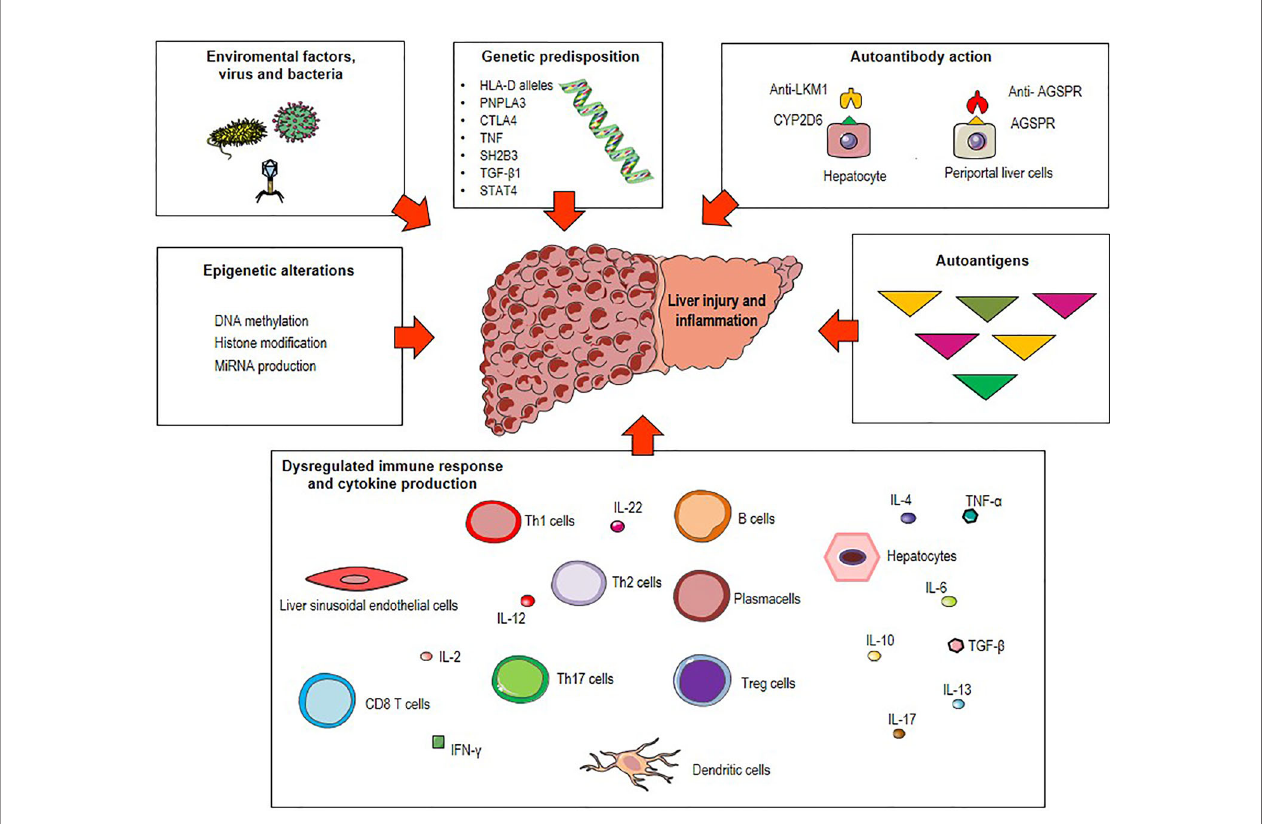
FIGURE 1 | Possible triggers of autoimmune hepatitis (AIH). Environmental factors (microbial products, drugs metabolites), epigenetic alterations (DNA methylation, histone modi fi cation and miRNA production) and genetic predisposition including polymorphisms of the human leukocyte antigen (HLA) genes (HLA class II DRB1 alleles), the Src homology 2-B adaptor protein 3 gene (SH2B3), the patatin-like phospholipase domain-containing protein 3 (PNPLA3), the cytotoxic T lymphocyte- associated antigen 4 (CTLA4), the tumor necrosis factor (TNF), the transforming growth factor- b 1 (TGF- b 1) and the signal transducer and activator of transcription (STAT) 4 are associated with great risk of developing AIH. Combination of these factors with pathogenetic mechanisms such as molecular mimicry, autoantibody production and dysregulated immune responses against liver autoantigens lead to immune tolerance breakdown and consequent liver injury and in fl